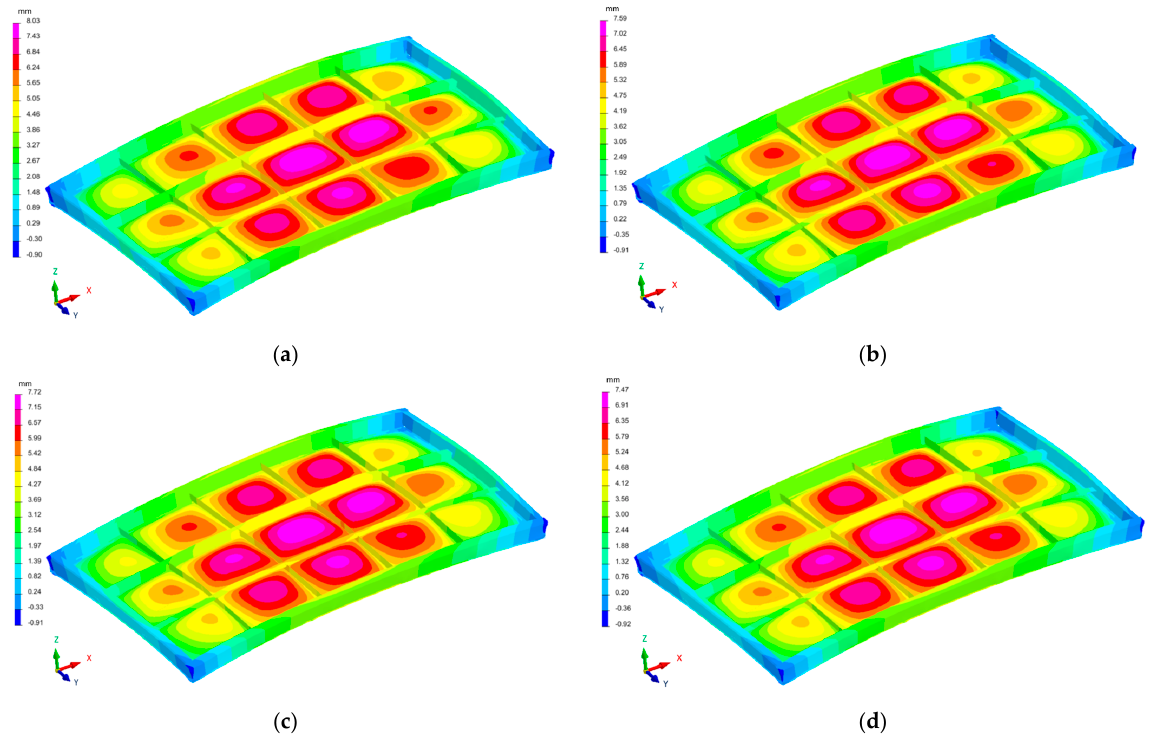
Figure 12. Distribution of the strain field of the industrial furnace wall panel in the Z direction; ( a )